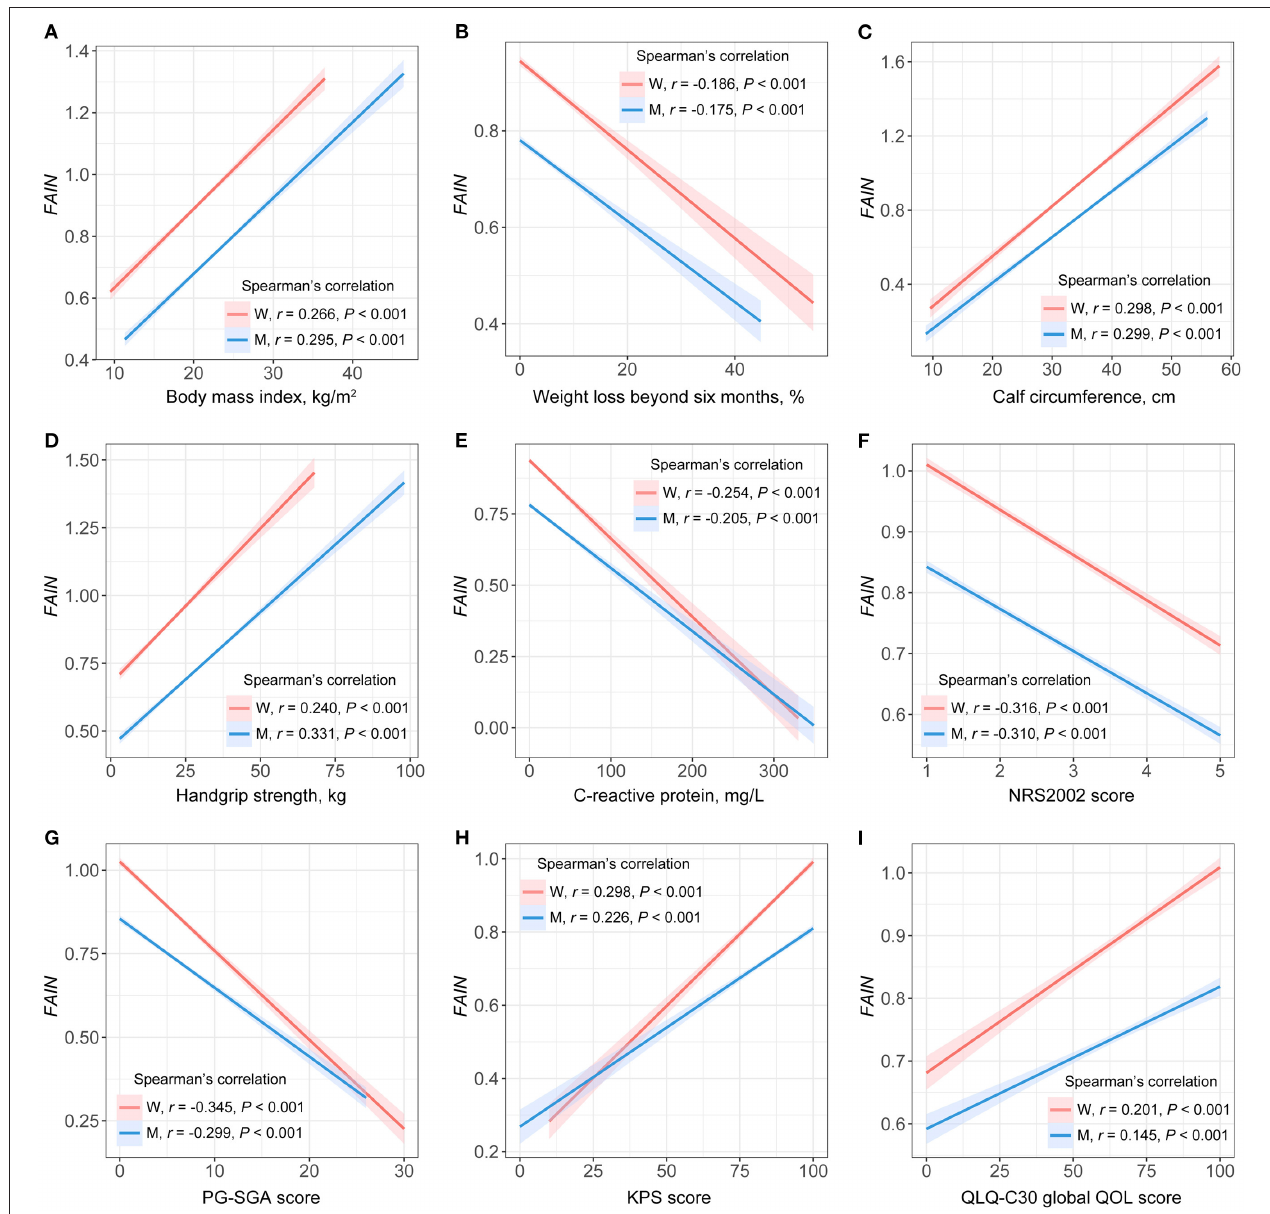
FIGURE 1 | Spearman’s rank correlations between the fat-age-inflammation (FAIN) index and patient characteristics. W, women; M, men; NRS2002, the Nutritional Risk Screening 2002; PG-SGA, the Patient-Generated Subjective Global Assessment; KPS, the Karnofsky Performance Status score; QOL, quality of life. (A) FAIN vs. body mass index. (B) FAIN vs. weight loss beyond six months. (C) FAIN vs. calf circumference. (D) FAIN vs. handgrip strength. (E) FAIN vs. C-reactive protein. (F) FAIN vs. NRS2002. (G) FAIN vs. PG-SGA. (H) FAIN vs. KPS score. (I) FAIN vs. QLQ-C30 global QOL